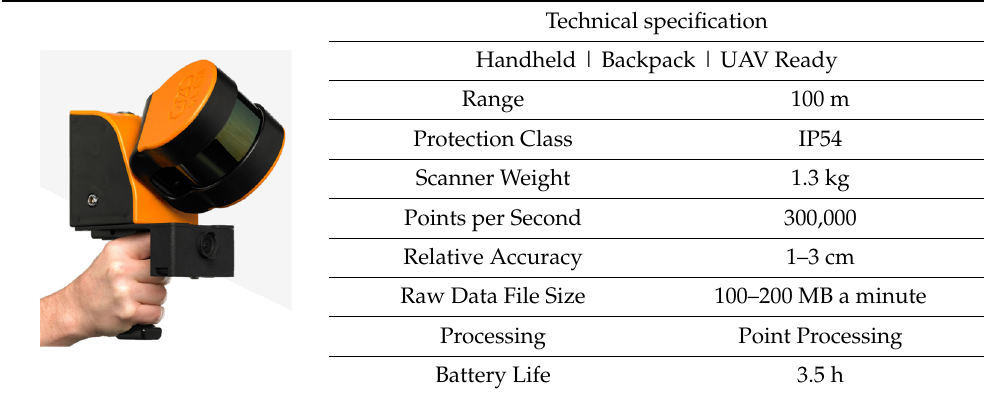
Table 2. Technical specification for the GeoSLAM ZEB Horizon (https://microsolresources.com/wp- content/uploads/2019/06/GeoSLAM-Family-Brochure.pdf, accessed on 24 November 2021).